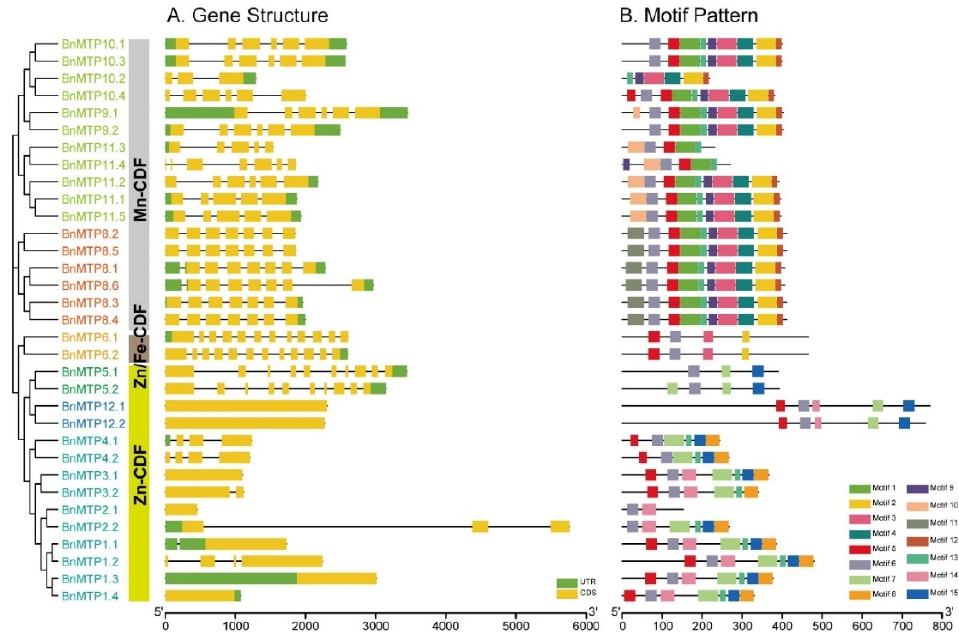
Figure 2. The gene structure and motif pattern of the MTP gene family in B . napus . ( A ) The exon– intron structure of BnMTP genes. Green boxes indicate 5 ′ - and 3 ′ -untranslated regions (UTR), yellow boxes indicate exons, and black lines indicate introns. ( B ) Conserved motifs of BnMTP proteins. Motif 1–15 identified by MEME analysis are displayed in different colored boxes.